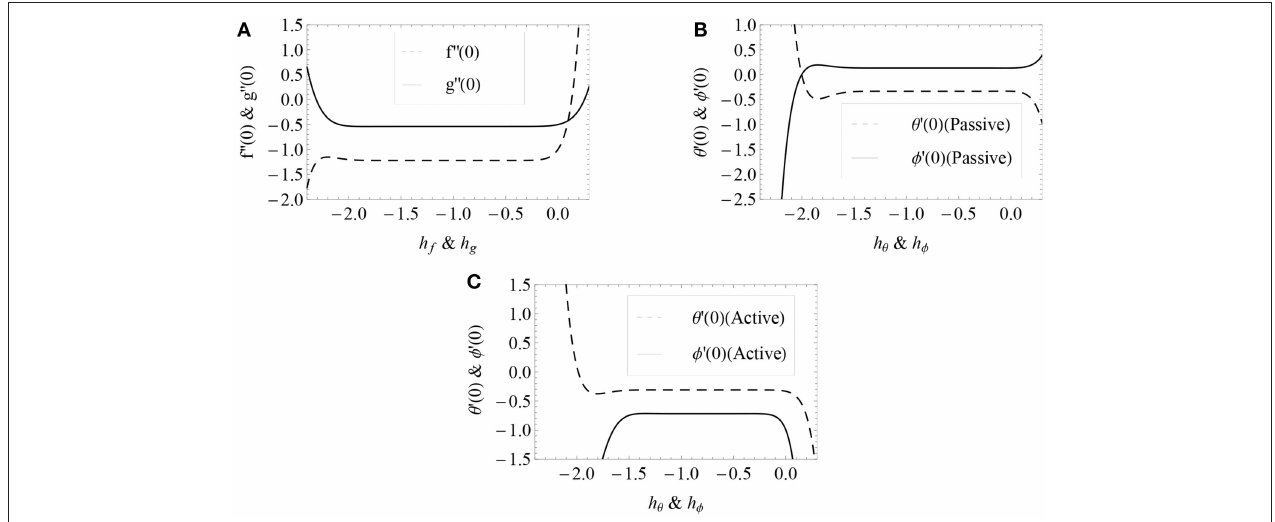
FIGURE 1 | h curves of f ′′ (0) & g ′′ (0) (A) and θ ′ (0) & φ ′ (0) for PC (B) and AC (C) with K